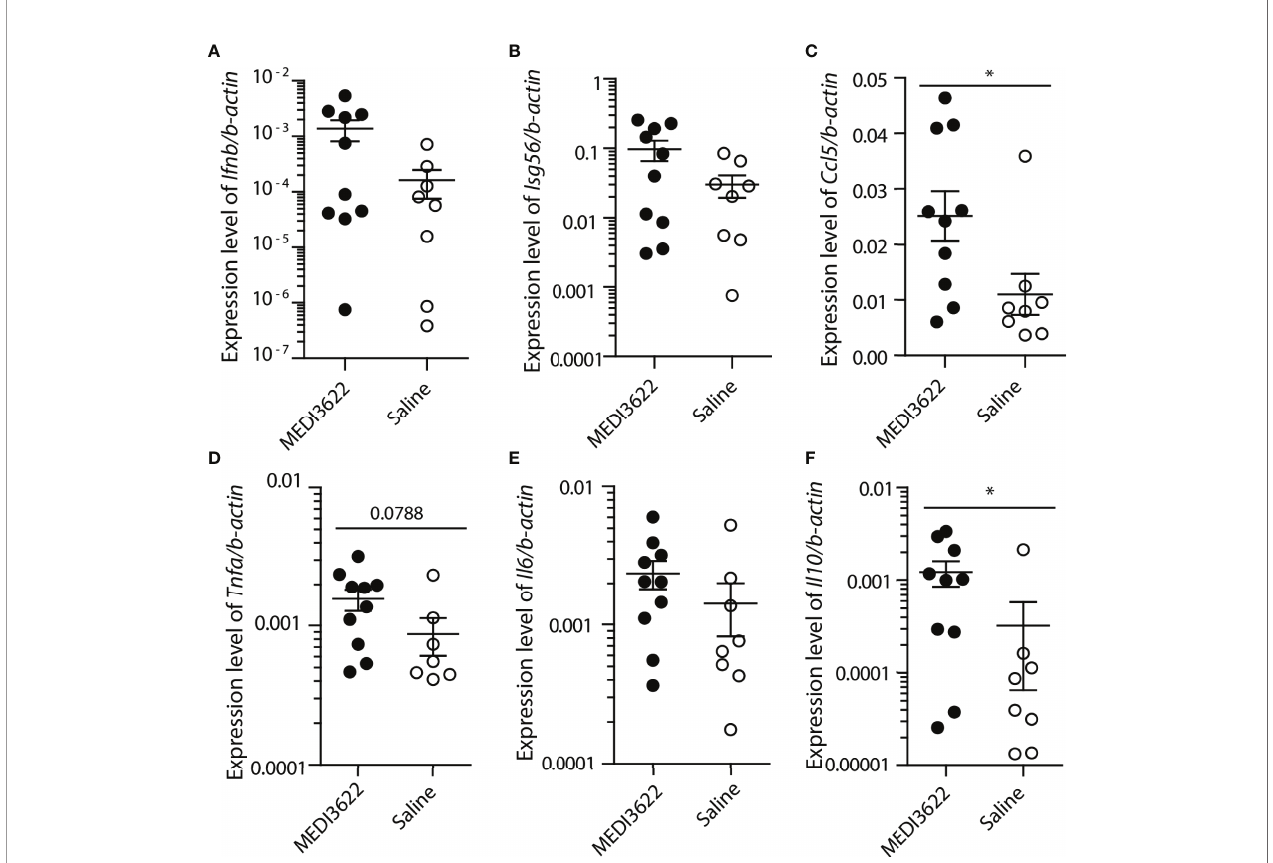
FIGURE 3 | Cytokine transcript levels of MEDI3622-treated mice are higher than or similar to those of control (saline-treated) mice during SARS-CoV-2 infection. RNA was extracted from lungs of mice infected with SARS-CoV-2, described in Figure 1 . (A – F) Transcript levels of genes were measured with quantitative RT- qPCR and normalized against the housekeeping gene b − actin. *p<0.05. This experiment was performed similarly 2 independent times with 10 mice per